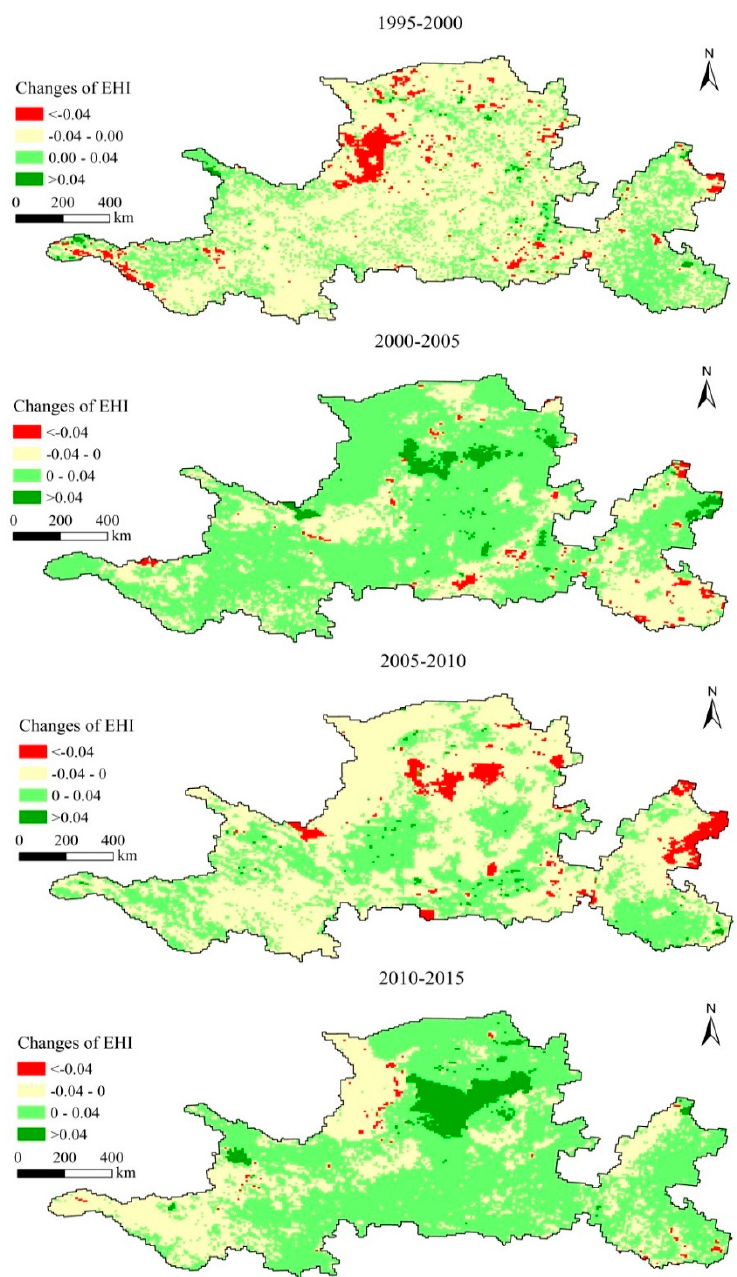
Figure 4. Changing trend of ecosystem health index from 1995 to 2015.